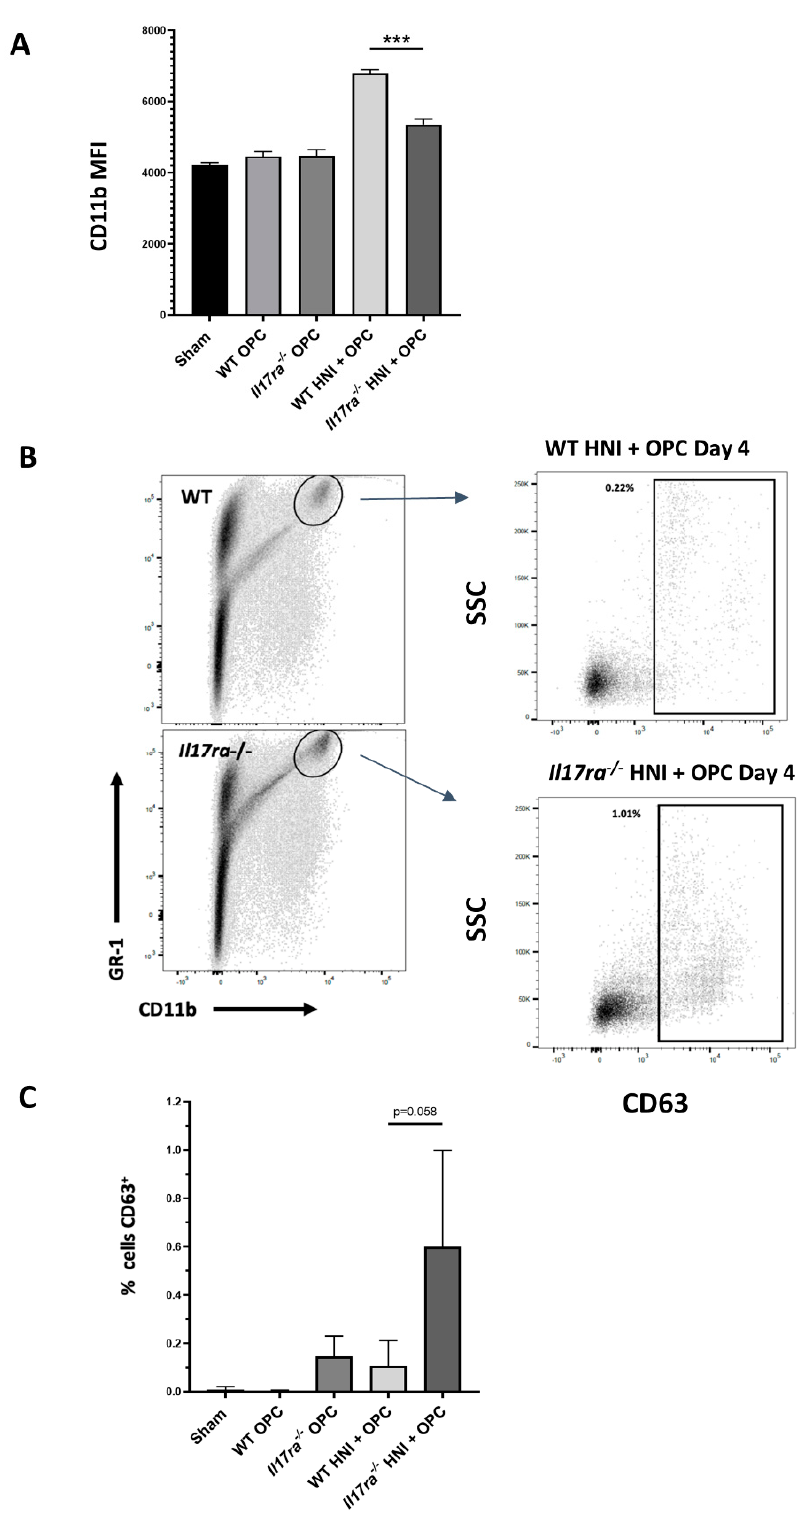
Figure 8. HNI exposure leads to oral neutrophil defects. ( A ) Quantification of flow cytometry results showing phagocytosis of GFP- Candida albicans by Gr-1+ neutrophils after subjecting mice to OPC and HNI + OPC (n = 3 mice per group) ( B , C ) Expression differences relative to GAPDH . Analyzed by ANOVA with Tukey’s post hoc. (n = 3 mice per group). (*** p < 0.001). Data representative of at least 2–3 experimental repeats.